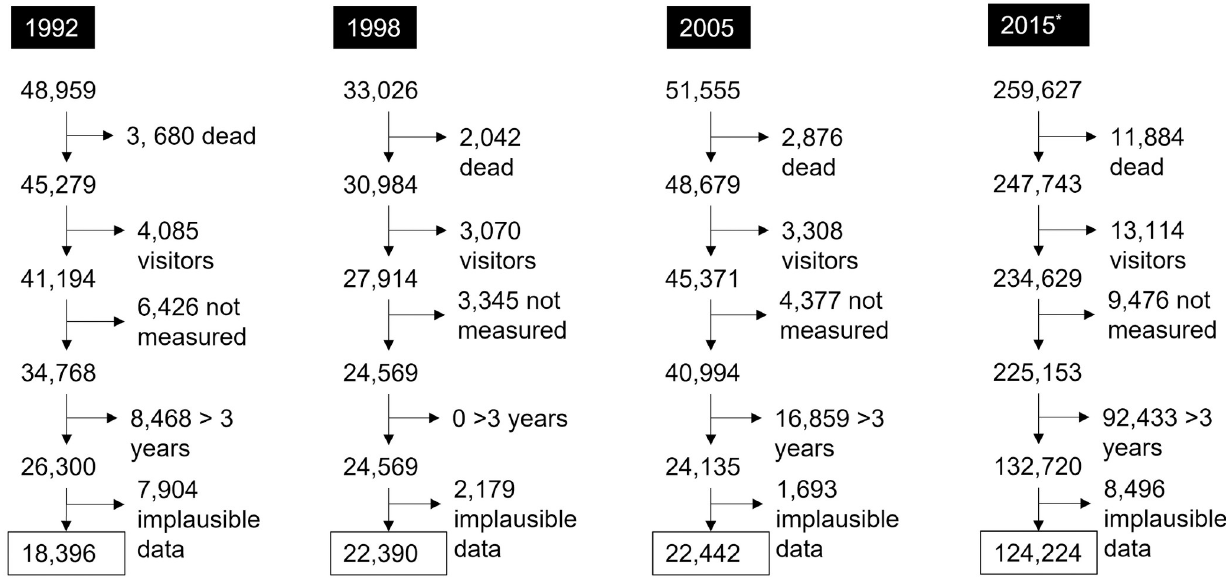
Fig 1. Flowchart demonstrating exclusions and final analytic sample from the NFHS in India included in this study. N AU : AbbreviationlistshavebeencompiledforthoseusedthroughoutFigs 1 (cid:0) 4 : Pleaseverifythatallentriesarecorrect : FHS, National Family Health Survey. � 2015 survey sample size was increased to derive estimates at the district levels. Characteristics of the cohort did not markedly change intra- and inter-surveys based on the different exclusion criteria (results not